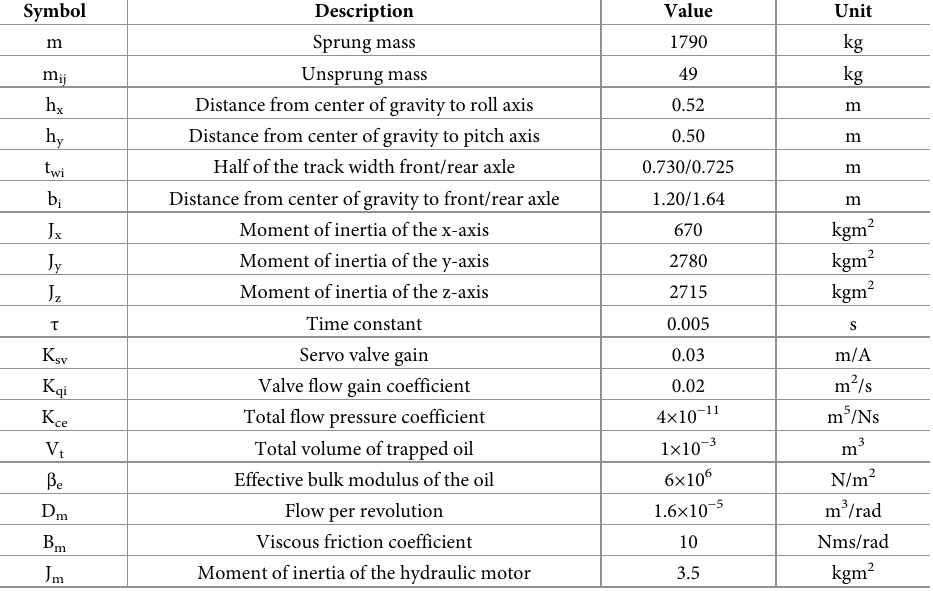
The parameters used for the simulation are shown in Table 2. Once the inputs have been determined, the simulation can be performed. This process is solved by the software MATLAB-Simulink. There are four cases, corresponding to four steering angles. In each case, Table 2. Specification